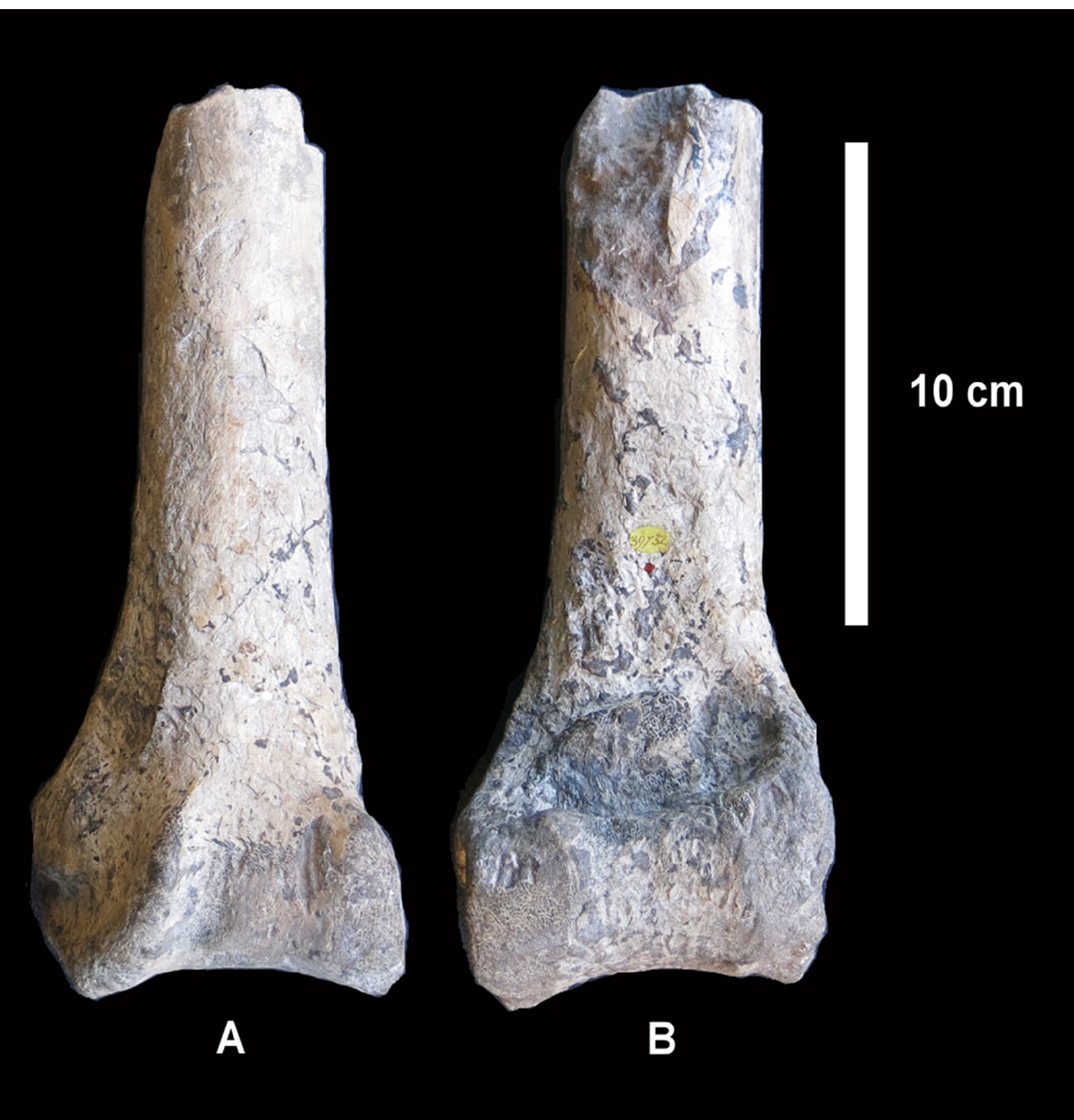
Figure 4. Distal part of the right tibiotarsus of an ostrich, from the ‘‘Siwalik hills, India’’ (exact locality and stratigraphic position unknown), collected and donated by P.J. Cautley, NHMUK PV OR 39732, in caudal ( A ) and cranial ( B ) views. Specimen referred to Struthio asiaticus by Davies [3] and Lydekker [9]. Contrary to Davies’s opinion, it is unlikely to belong to the same individual as the type specimen of S. indicus , which was collected by J. Colvin. Since the type specimen of Struthio asiaticus does not include a tibiotarsus, this specimen may be referred to as Struthio cf. asiaticus.